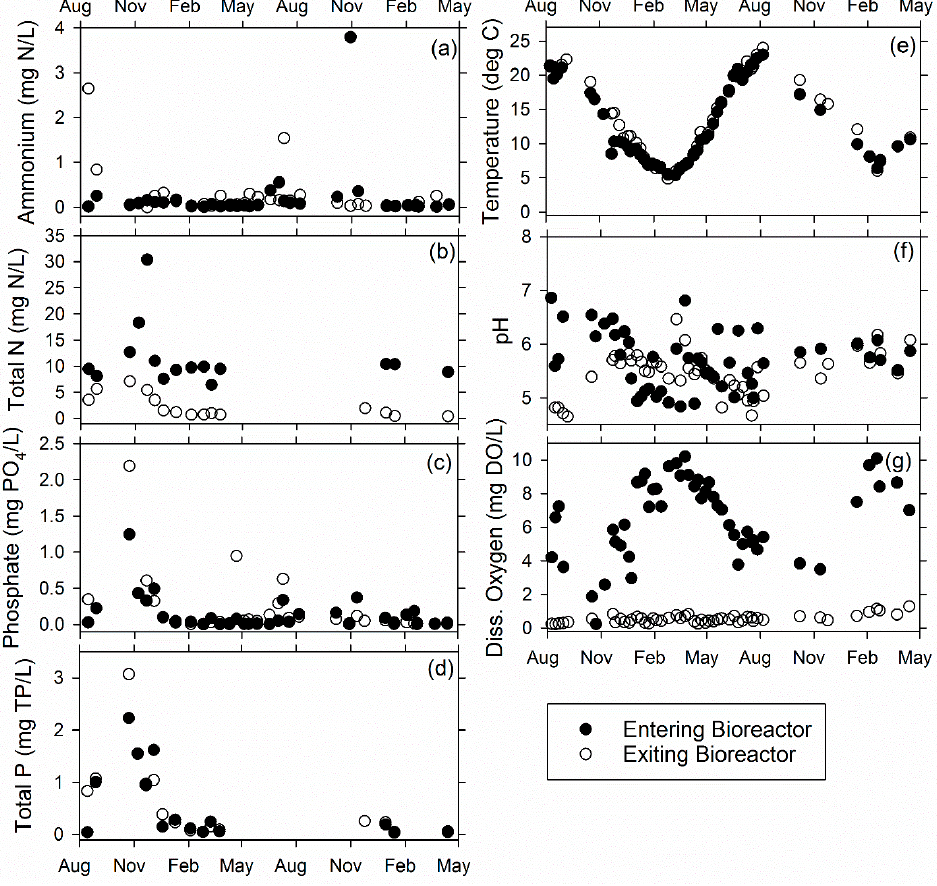
Figure 7. Queen Anne Farm bioreactor ( a ) ammonium; ( b ) total nitrogen; ( c ) phosphate; ( d ) total phosphorus; ( e ) water temperature; ( f ) water pH; and ( g ) dissolved oxygen concentrations of